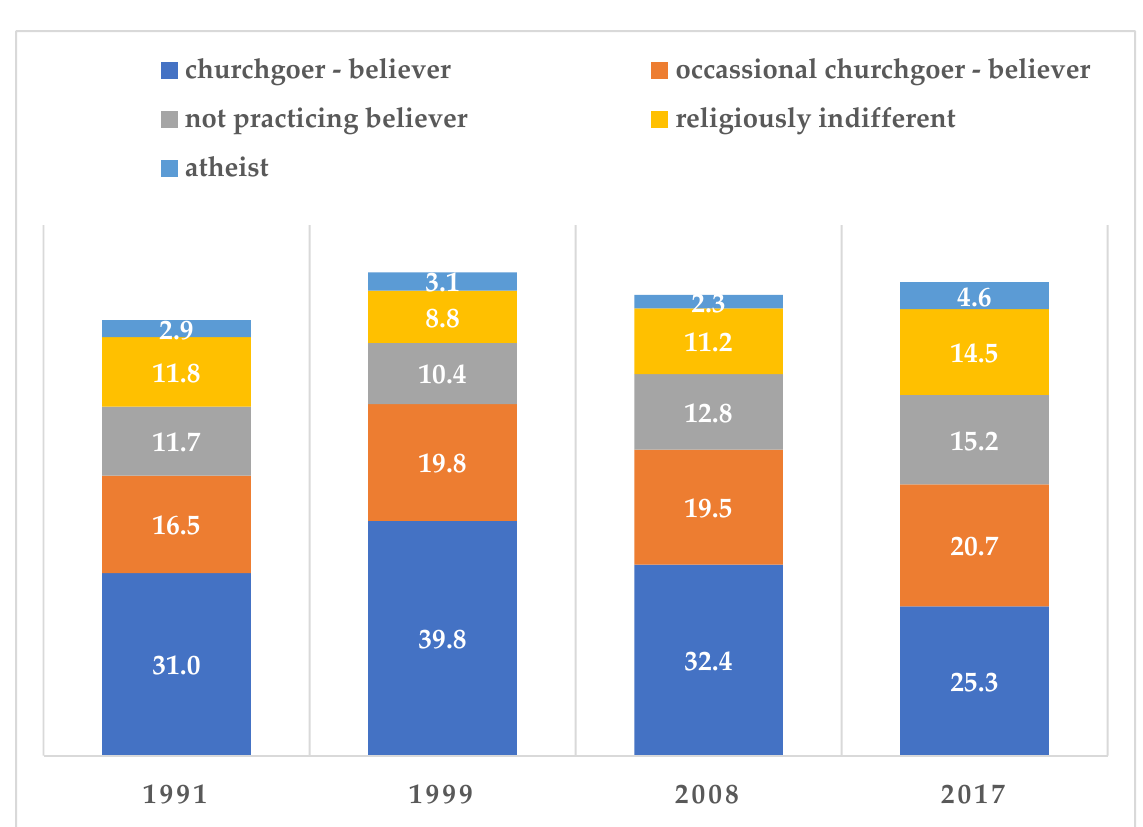
Figure 1. Saturation of the five basic types of worldview in 1991–2017 (in %). It is evident from the presented data that, in terms of the order and dominance of individual types, no major changes have taken place in Slovakia in more than a quarter of a century. The churchgoer believer type of religiosity remains consistently dominant, but it seems to be showing a significant decline after a significant increase until 1999 (up to almost 40% of respondents). By 2017, this group had gradually shrunk to 25% of the total population. But there was a very slight increase in the group of occasional churchgoer believers and not practicing believers. After a decline in the proportion of the religiously indifferent in 1999, there was a resurgence, and by 2017 they were a larger proportion of those surveyed than in 1991. In Slovakia, the proportion of atheists has also increased,